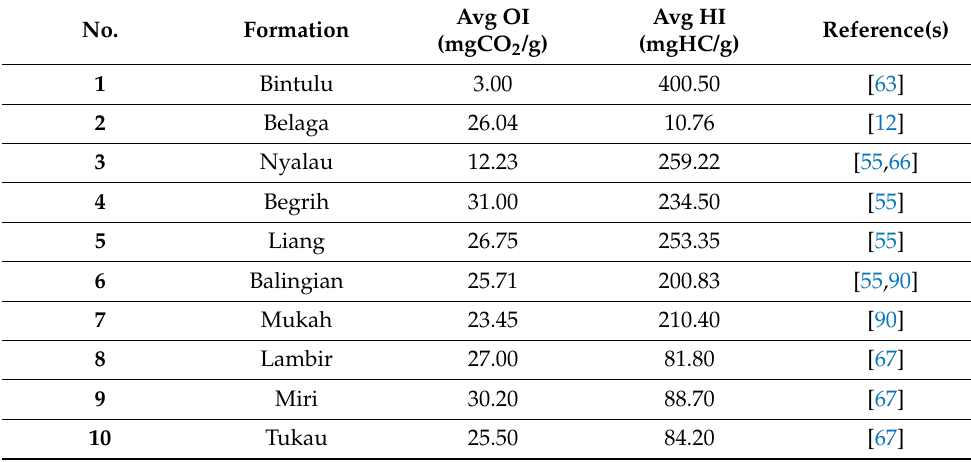
Figure 14. TOC vs. S2 plot of formations in Sarawak showing hydrocarbon yield potential and type of kerogen. Table 14. Average OI and HI values of formations in